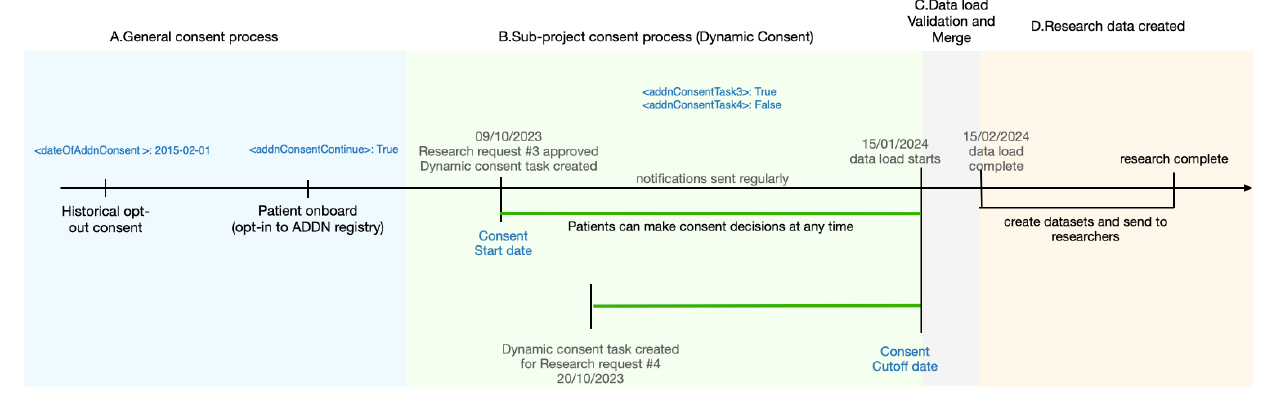
Figure 7. The complete ADDN Consent workflow.